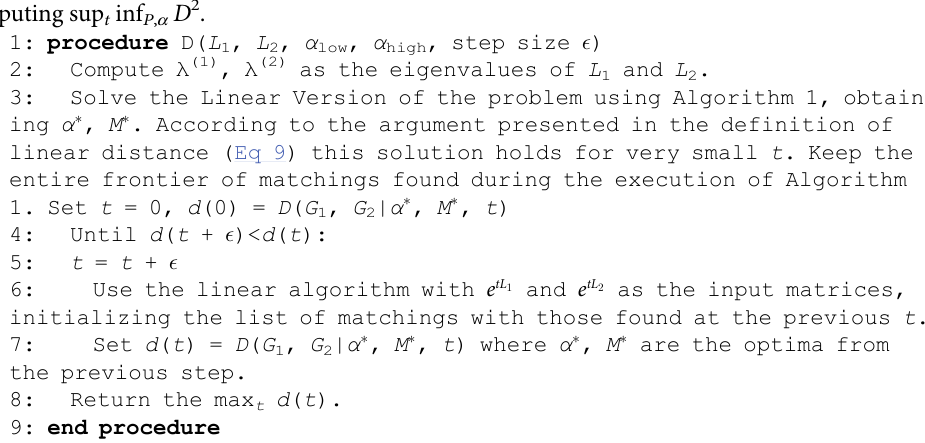
Algorithm 2 Abbreviated pseudocode for the algorithm described in Section 4.1.2, for com- puting sup inf D 2 t P , α